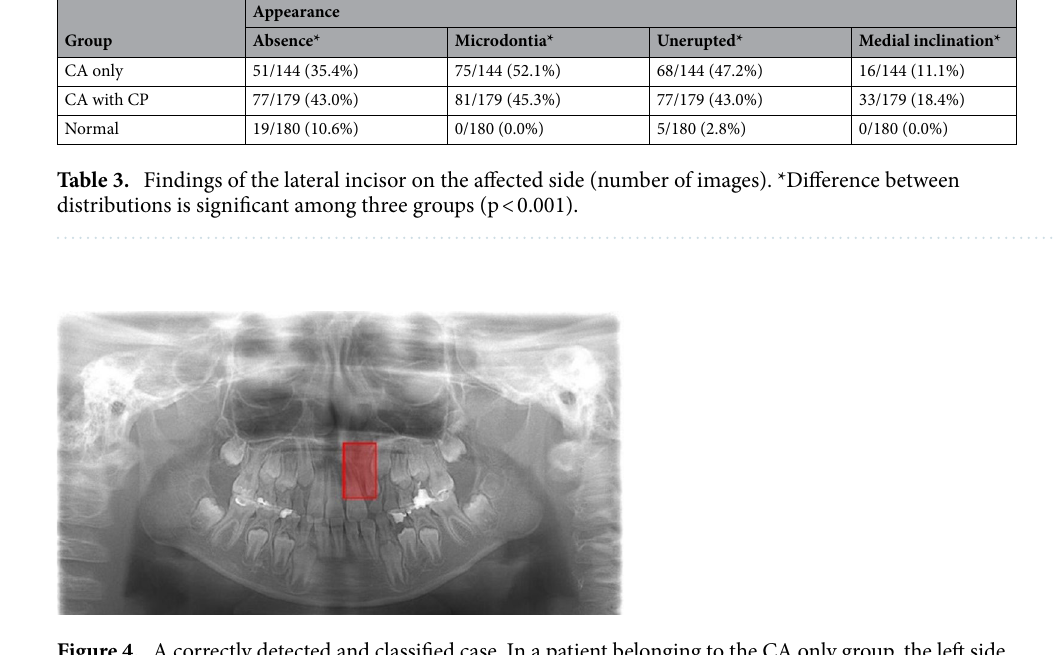
Figure 4. A correctly detected and classified case. In a patient belonging to the CA only group, the left side CA was correctly detected and classified into the CA only group, showing a red bounding box. The inferior line of the piriform aperture on the affected side is situated at an inferior level relative to that on the contralateral normal side. The left lateral incisor shows findings of unerupted microdontia.